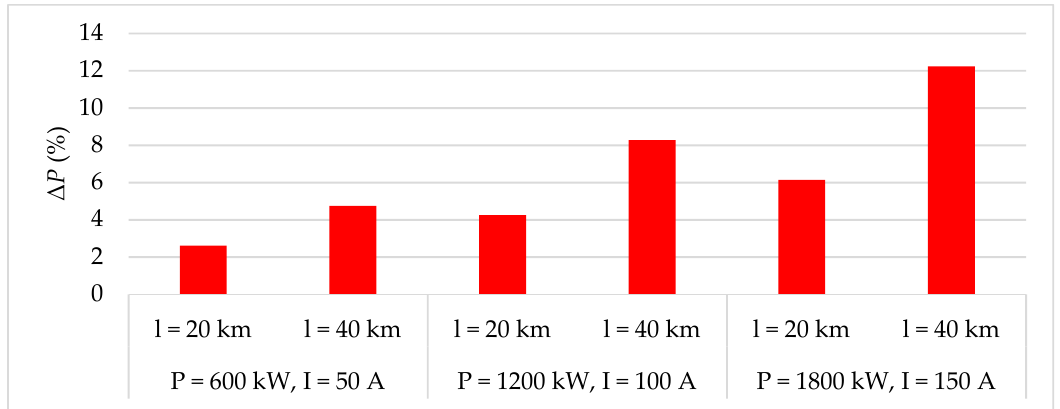
Figure 23. The comparison of the APLs for three types of active powers for conductor ACSR 95/15.